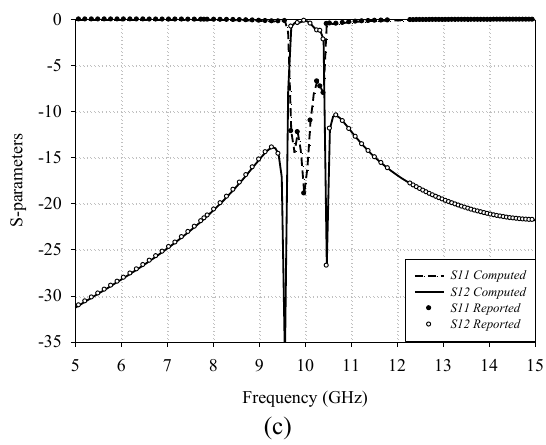
Figure 13. FSS design for sharp side band response based on SIW. (a) Cascading, (b) Shunting, (c) frequency response. Dashed and Solid lines show computed results at dept. of ECE, NITT. Bubbles show the reported results from Figure 3 in [31].